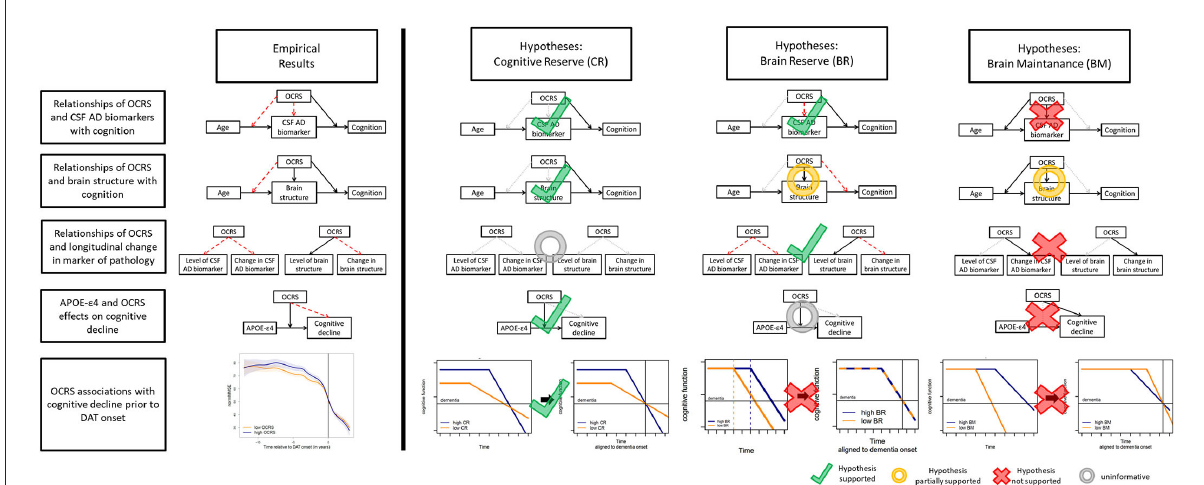
FIGURE6 Graphical illustrations of hypothesis test results for CR, BM, and BR. In the graphical illustrations of hypotheses (right side) , black arrows linking boxes indicate expected association, red dashed arrows indicate associations inconsistent with the predictions by the respective resilience concept, and gray dotted arrows indicate no expectation regarding association by the respective resilience concept. Arrows pointing toward other arrows indicate an expected statistical interaction effect. In the bottom row, plots on the left illustrate the typical development of cognition over time. Bold arrows indicate the alignment of time to the onset of dementia (horizontal black line) that is a shift along the x-axis. In the graphical illustrations of empirical results (left side) , black arrows indicate supported associations while red arrows indicate non-significant associations not supported by our data. OCRS, occupational cognitive requirement score; APOE- ε 4, apolipoprotein E ε 4 allele; CSF, cerebrospinal fluid; CR, cognitive reserve; BM, brain maintenance; BR, brain